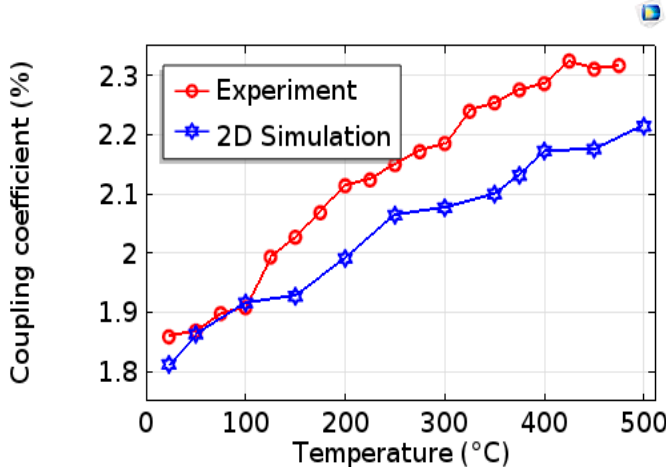
Figure 7. Evolution of experimental and simulated electromechanical coefficients versus temperature.